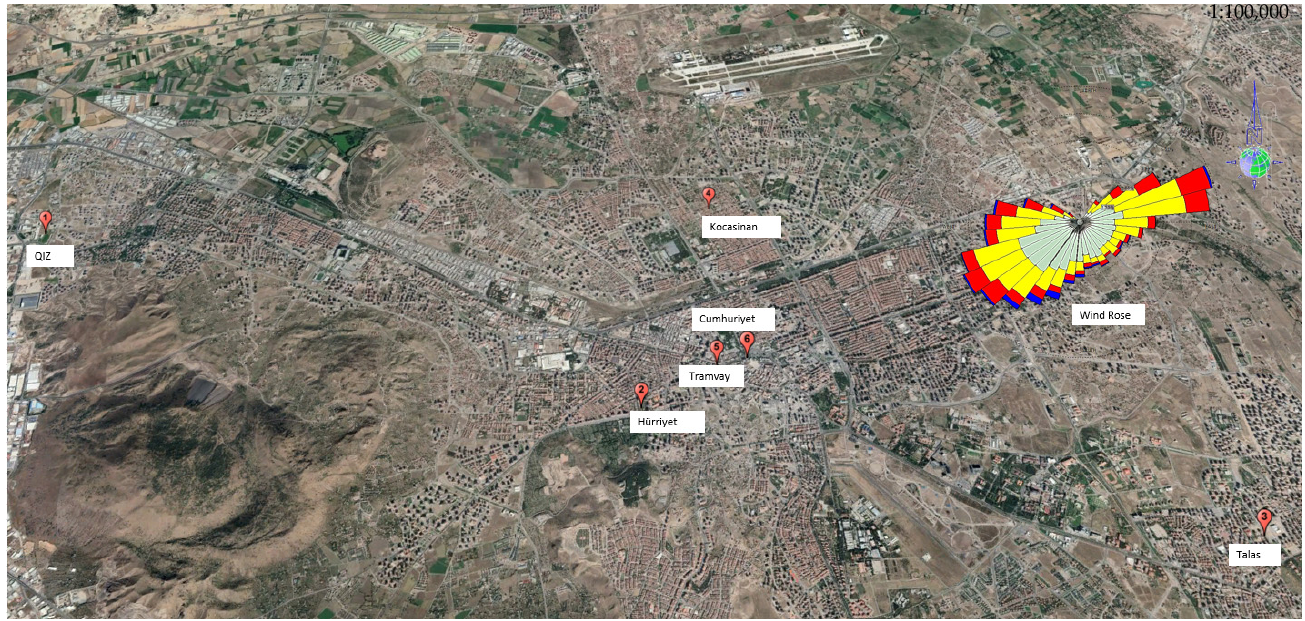
Figure 2. Wind rose prepared according to the 2014 data of Meteorology Station no. 17195, in Kayseri Province; locations of the six sampling points [28].